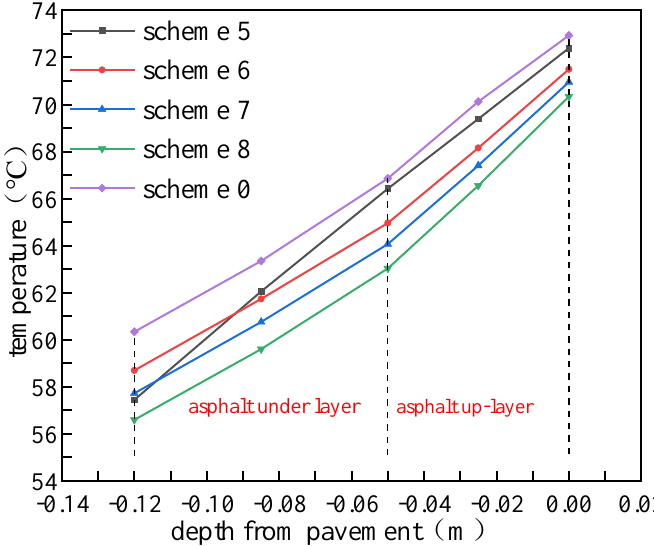
Figure 9. Temperature distributions of the asphalt layer with different PCM mixing ratios on July 15.